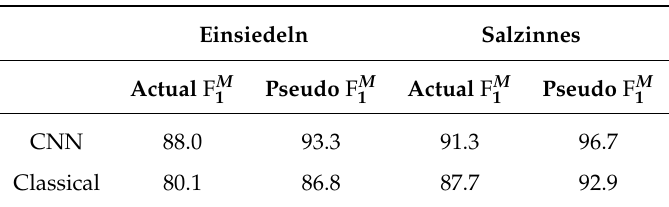
Table 6. Performance comparison between the CNN-based approach and a set of classical algorithms for the document processing task, in terms of F M 1